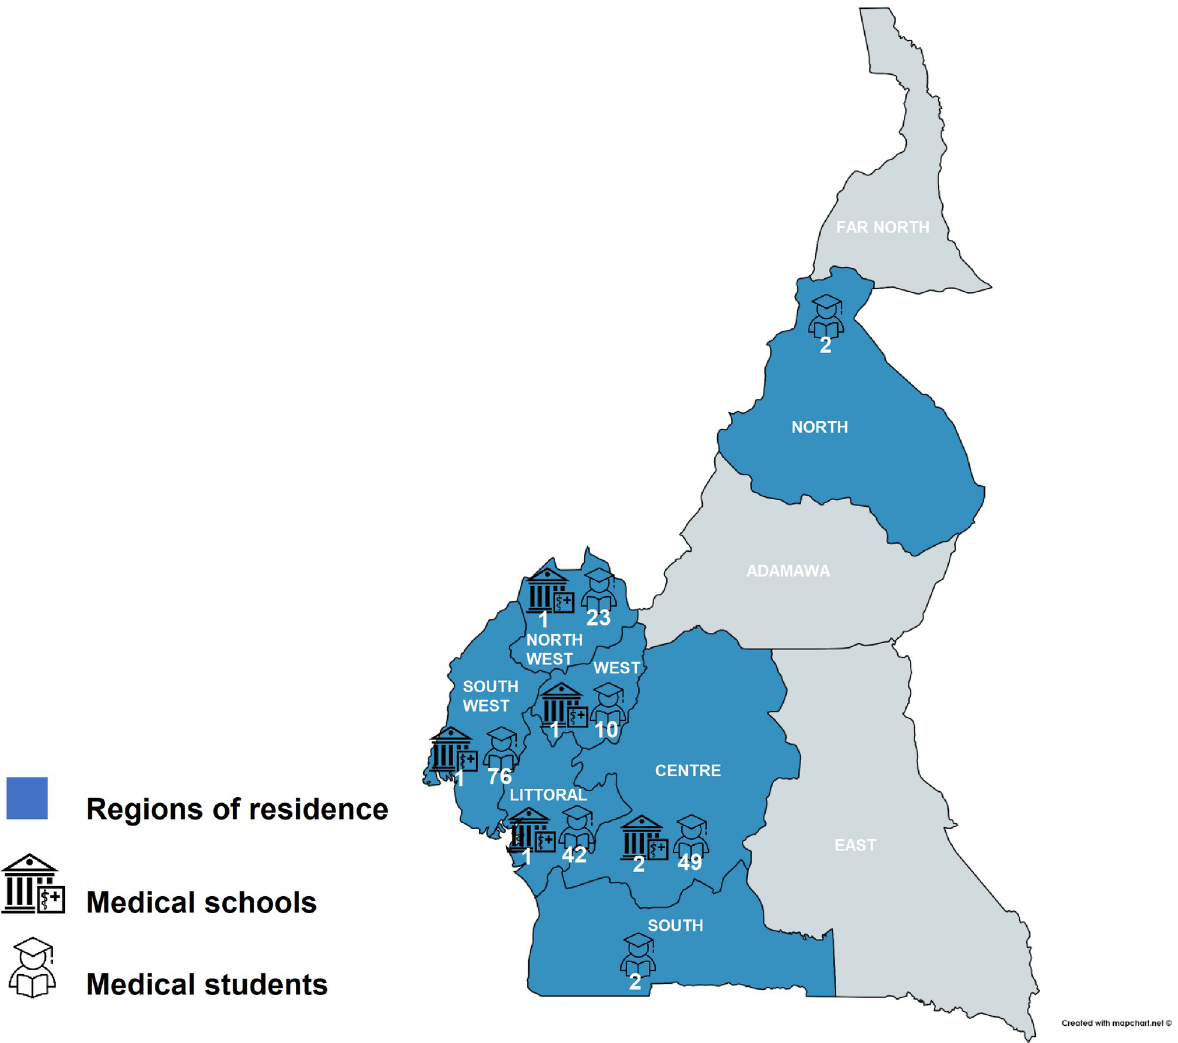
Fig 1. Medical school locations and permanent residencies of medical students. Regions of permanent residence are colored in blue. Buildings represent medical schools, and icon heads donning graduate caps represent medical students. The number of medical students and medical schools is placed below the corresponding